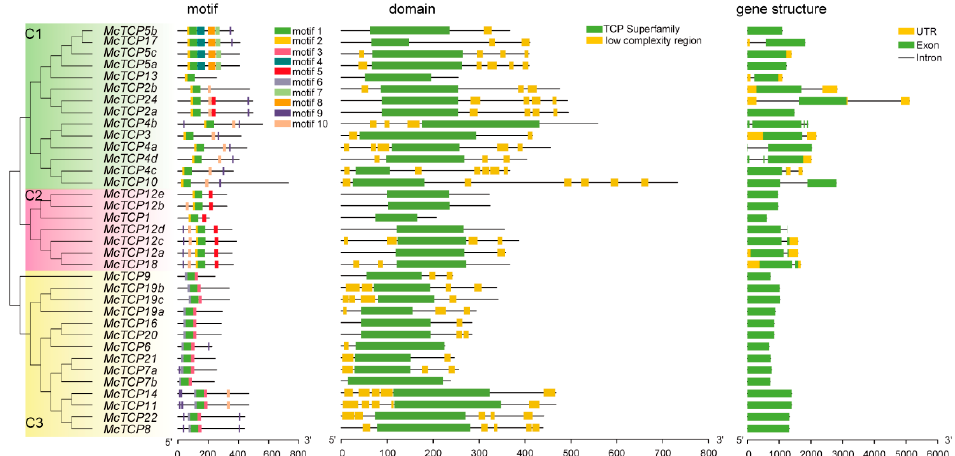
Figure 3. Motif, domain and gene structure analyses of TCP family members. Rectangles with different colors represent different motifs, domains, UTRs and exons, respectively.